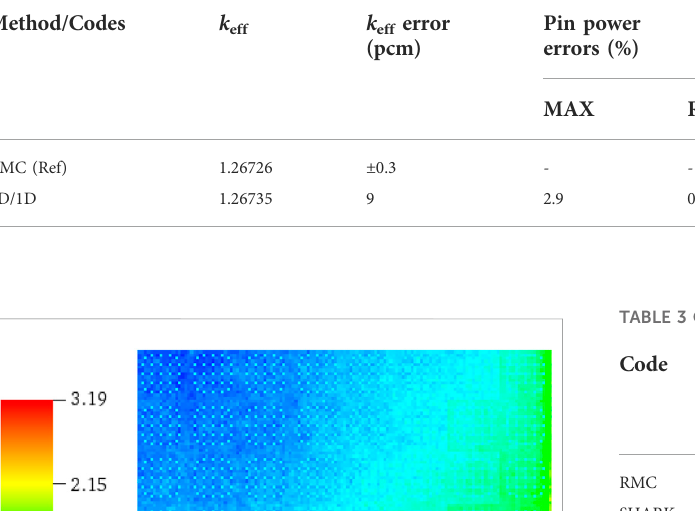
TABLE 2 Calculation results of macroscopic BEAVRS core problem.